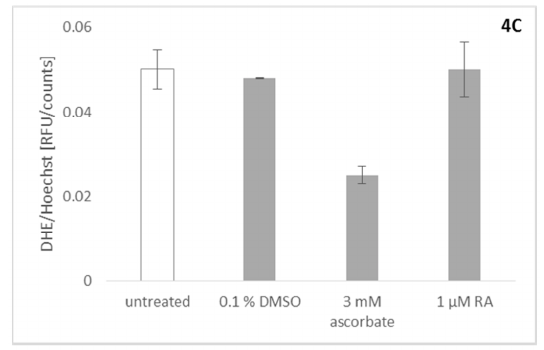
Figure 4. Effects of rosmarinic acid (RA) on Nox2 ( A ) and Nox5 ( B ) activity and control for ROS scavenging activity ( C ). Data are shown as mean (± SD) of nine independent experiments. ( A ) Rosmarinic acid was investigated for its inhibitory activity on Nox2. For the activation of Nox2, peripheral blood mononuclear cells (PBMCs) were treated with 2 ng/mL phorbol 12-myristate 13-acetate (PMA). Rosmarinic acid (1 µM) inhibits ROS production, as well as 1 µM diphenyleneiodonium (DPI); ( B ) Measuring the chemiluminescent signal on Nox5 overexpressing HEK cells after exposure to DPI a reduction of the luminescent signal was detected. However, concentrations up to 20 µM rosmarinic acid applied on the same cell system showed no effect, indicating that rosmarinic acid is not a universal Nox inhibitor; ( C ) Potential effects of rosmarinic acid on the ROS production by the mitochondrial respiratory chain have been investigated. For this approach, the respiratory chain was inhibited by the application of rotenone. The controls ascorbate and rotenone show a decrease and an unaffected mitochondrial ROS signal respectively onto U2OS. In its activity, rosmarinic acid resembles the negative control, showing no effect on mitochondrial ROS production.